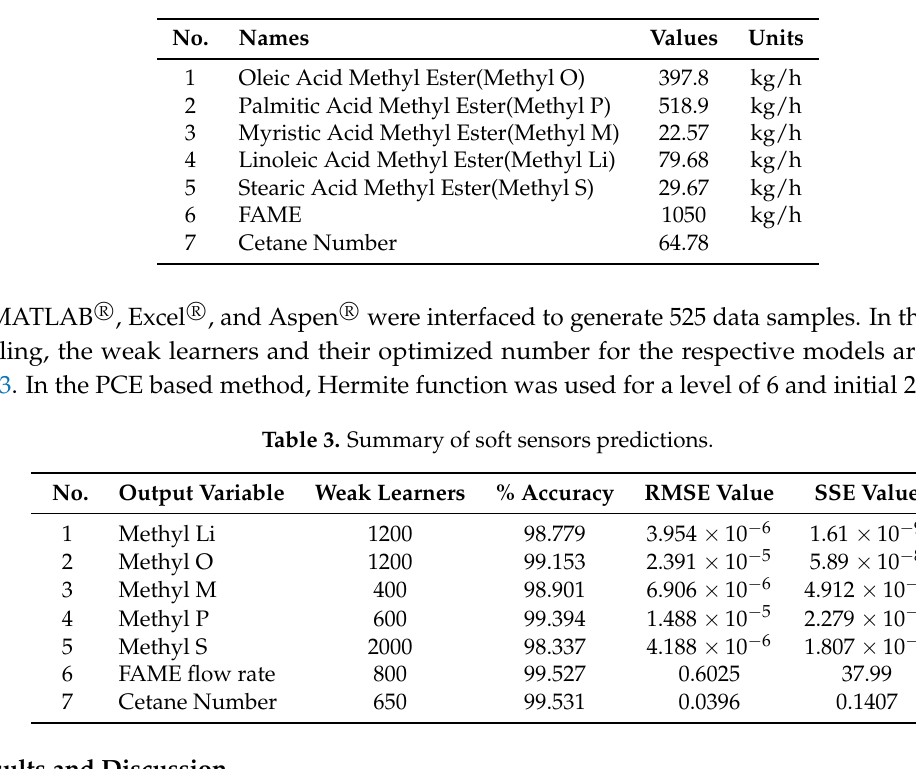
Table 2. Process output variables used for ensemble learning.